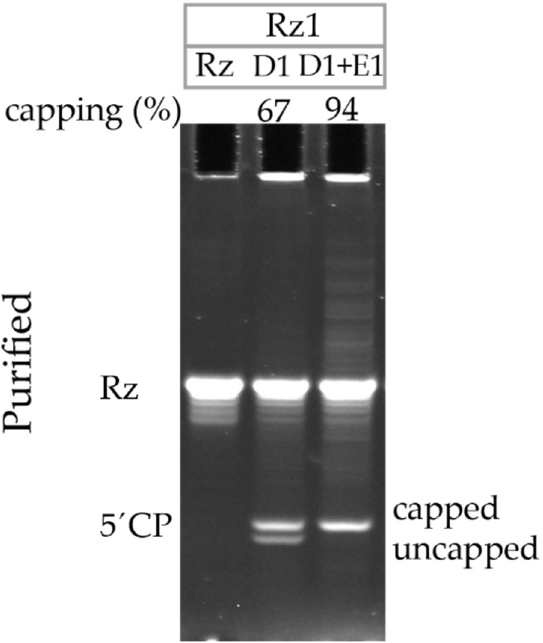
Figure 5. Ribozyme-mediated cleavage assay detects an increase in capping efficiency after enzy- matic capping of co-transcriptionally capped IVT mRNA. GCG transcription start site (TSS), hAg, U-containing IVT mRNAs, which were co-transcriptionally D1 capped or D1 + enzymatically capped (D1 + E1), were Rz1 cleaved, silica-column purified, and visualized using 21% PAGE, 8 M urea. Rz: Ribozyme; 5 ′ CP: 5 ′ cleavage product.